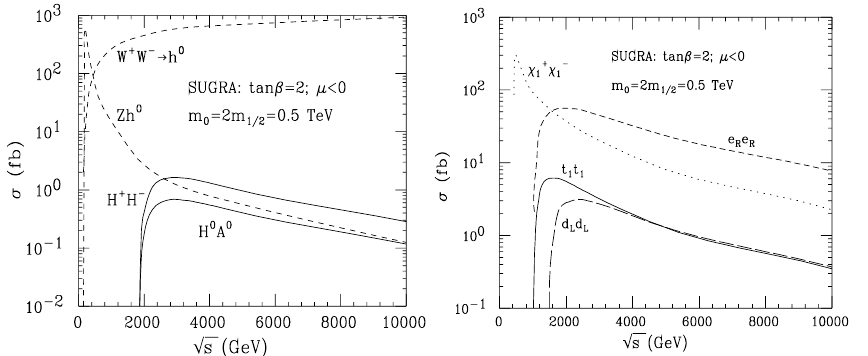
FIG. 11. Cross sections for pair production of Higgs bosons and scalar particles at a high energy muon collider. From Ref. [83].